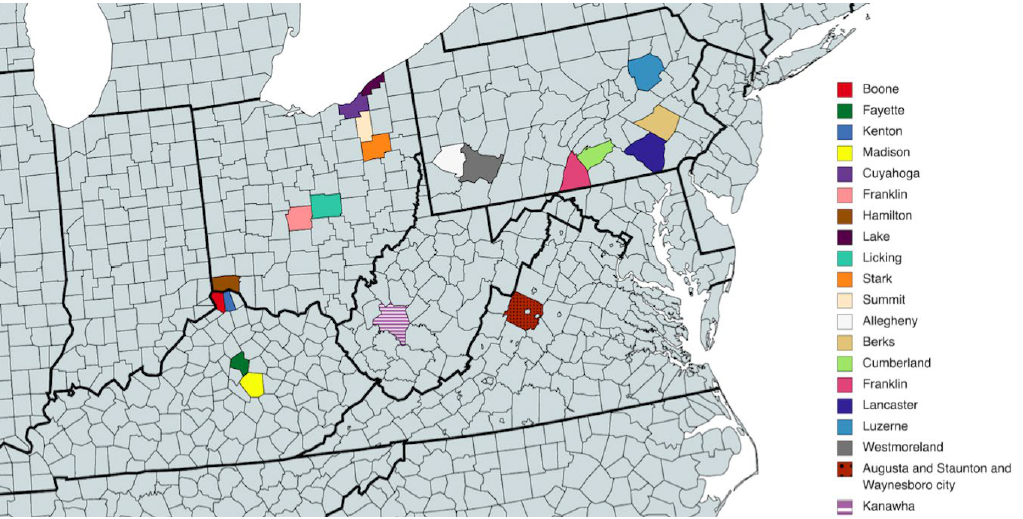
Figure 2. Counties included in the analysis on lung cancer screening (map created with mapchart.net).